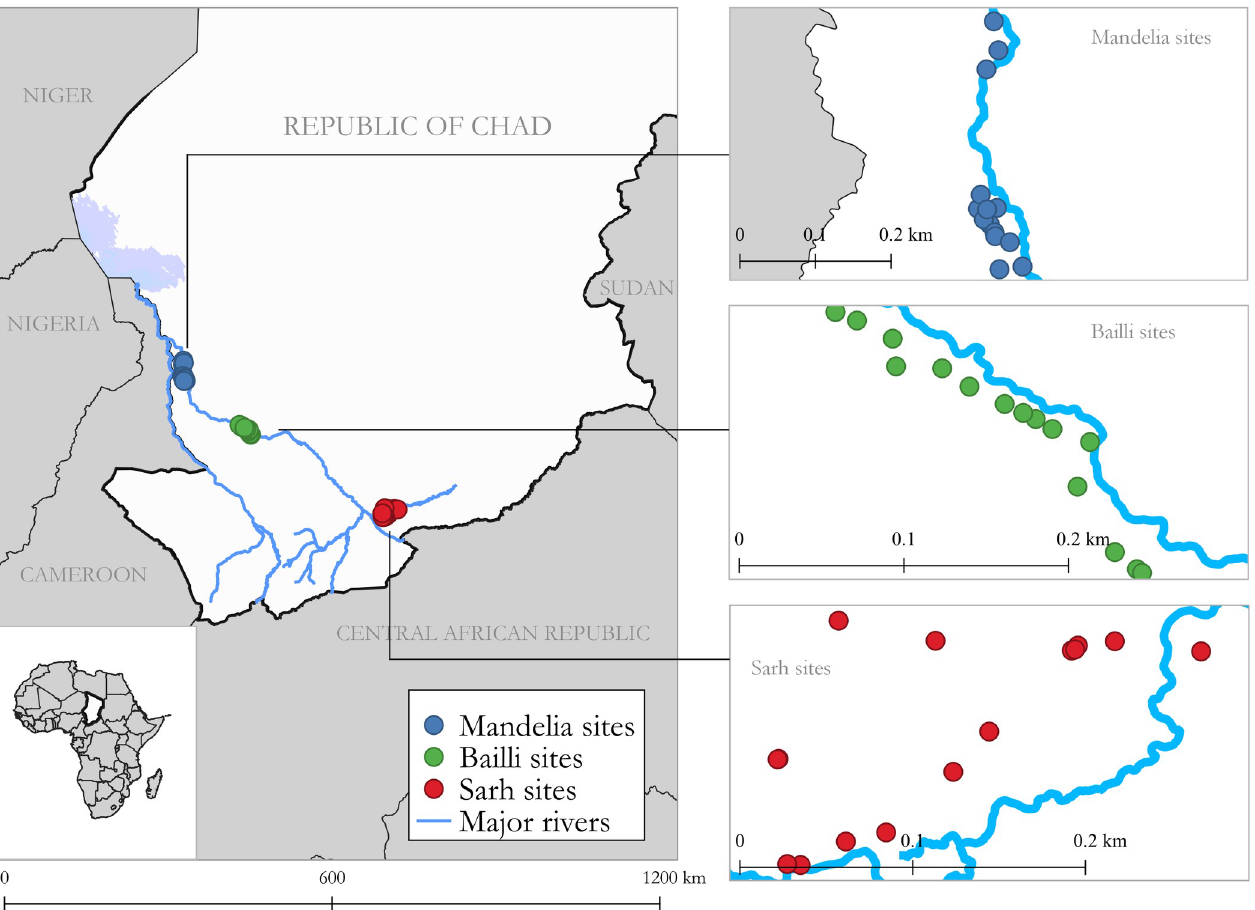
Fig 1. Map of southern Chad showing the locations of 45 villages purposefully selected for participation in the survey to evaluate the Chad Guinea Worm Eradication Program active surveillance system, September 2019.